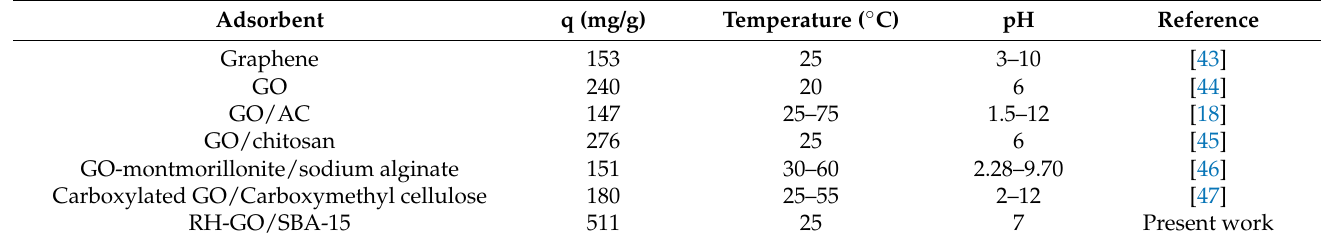
Table 3. Comparison of adsorption capacity for MB adsorption onto different GO-containing adsorbents. Adsorbent q (mg/g)